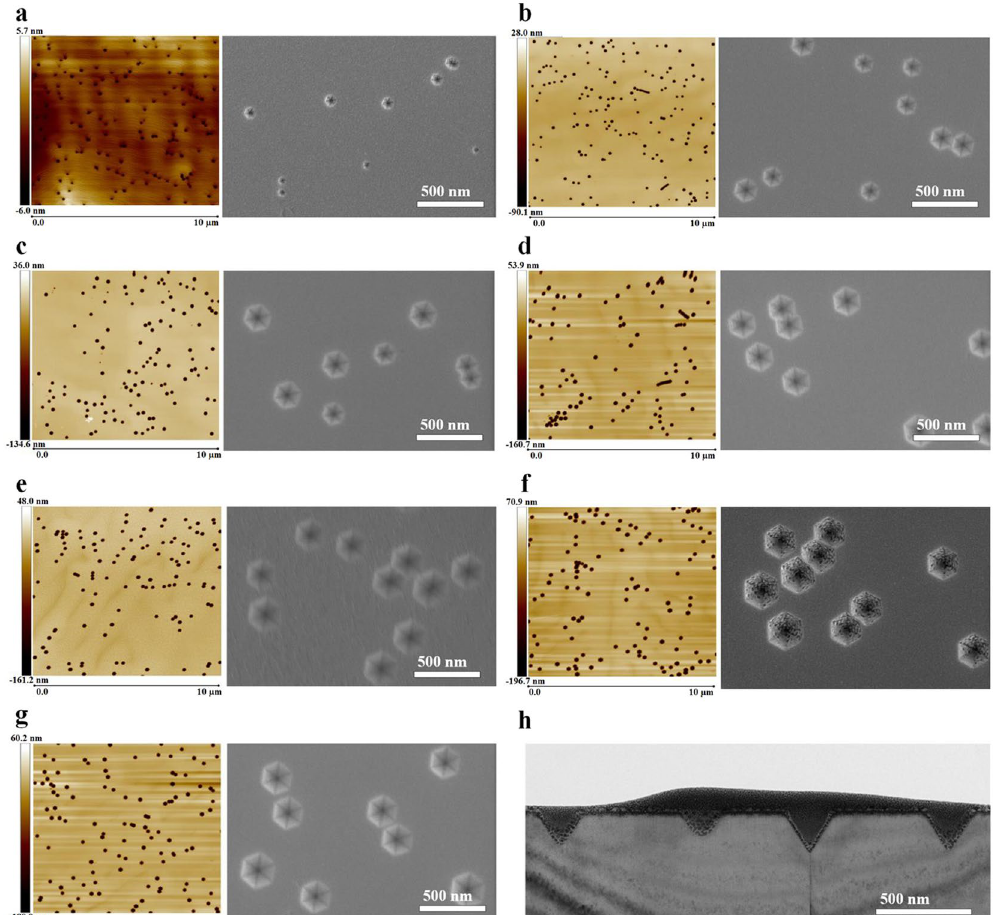
Figure 2. 10 × 10 μ m 2 AFM scans and top-view SEM images of the green In 0.25 Ga 0.75 N/GaN MQWs grown on ( a ) 0, ( b ) 2, ( c ) 4, ( d ) 6, ( e ) 8, ( f ) 10 periods of In 0.06 Ga 0.94 N/GaN SL and on ( g ) a low-temperature GaN layer. The V-pit diameter is proportional to the number of SL periods. The thickness of the low-temperature GaN layer is equal to that of 6 periods of SL. ( h ) Cross-sectional TEM image of an MQW sample showing V-shaped pits.